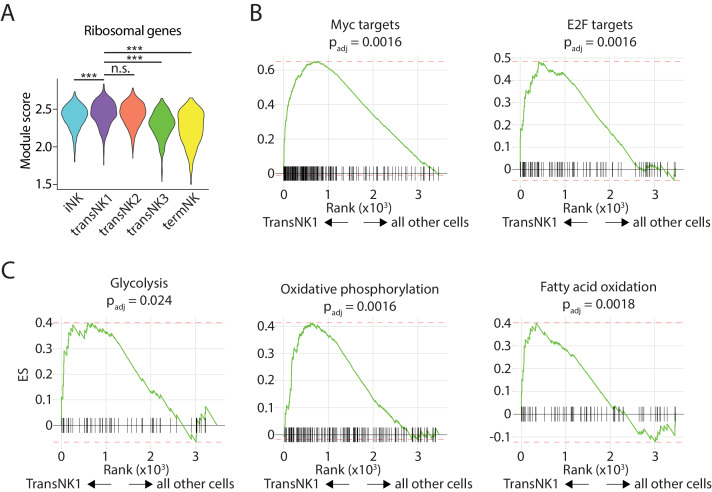
Unique features associated with tranNK1 cluster.(A) Module scores were calculated using all the genes encoding ribosomal subunits and plotted via violin plots. Statistical analysis was conducted using Two-way ANOVA followed by Tukey Honest Significant test. ***p<0.0001 (B, C) Significant enrichment of MYC, E2F (B) and metabolic pathways (C) in the tranNK1 cluster compared to all other cells.